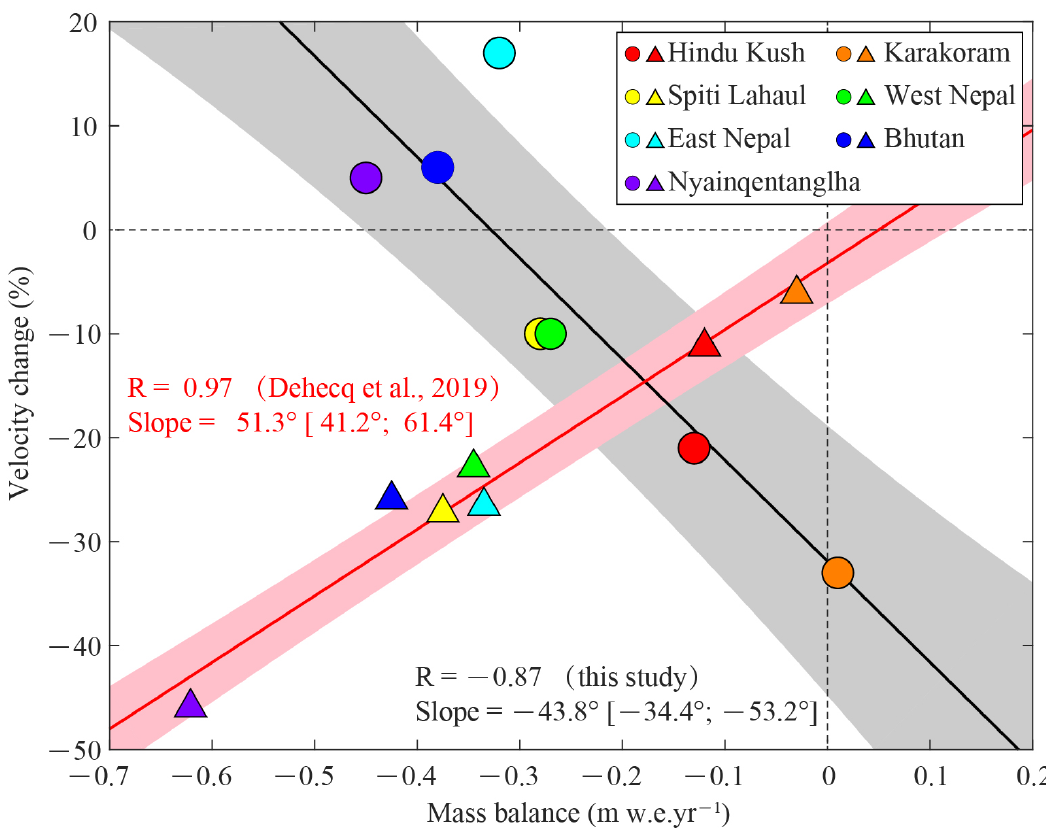
Figure 5. Glacier surface velocity changes versus mass balance. Mass balance data were taken from [7]. Shaded bands indicate 68% confidence interval. Winter velocity changes (filled circles, in this study) are negatively correlated with mass balance, with a correlation of R = − 0.87. Summer velocity changes (filled triangles, [9]) are positively correlated with mass